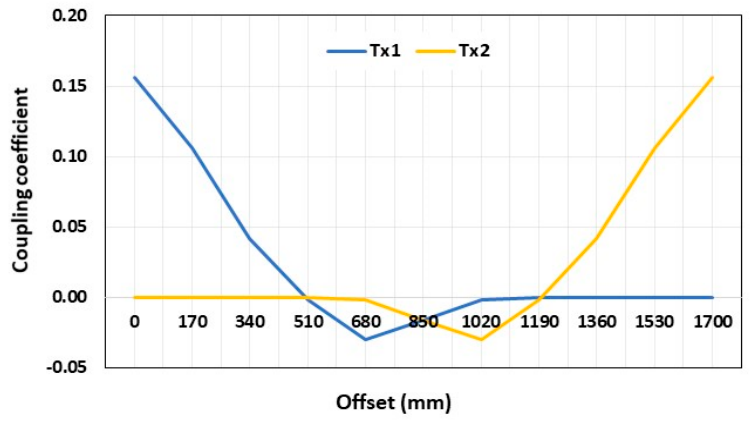
Figure 10. Variation of the coupling coefficient for every step of the Offset in the CP–CP configuration.